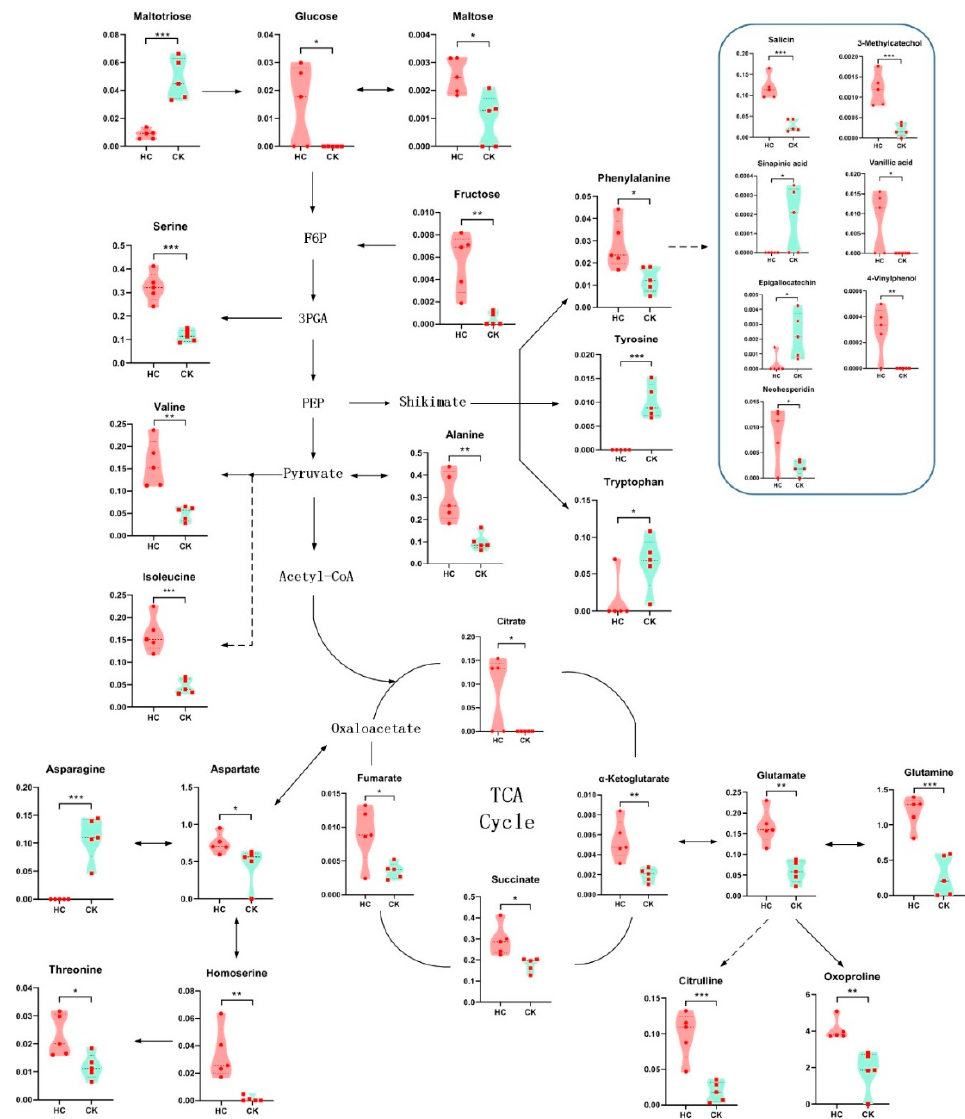
Figure 3. Changes in metabolites of the metabolic pathways in the HC treatment (HC) and the control (CK). The values on the Y-axis indicate the relative content of metabolite. “*”, “**”, and “***” represent significant differences between the HC treatment (HC) and the control (CK) at the p < 0.05, p < 0.01, and p < 0.001 levels.